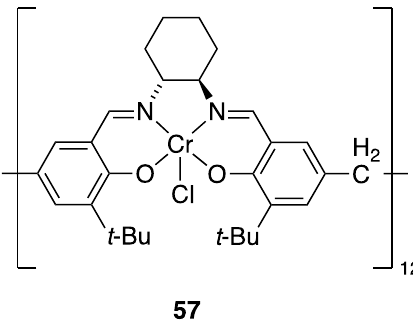
Figure 22. Polymeric Cr–salen complex 57 .